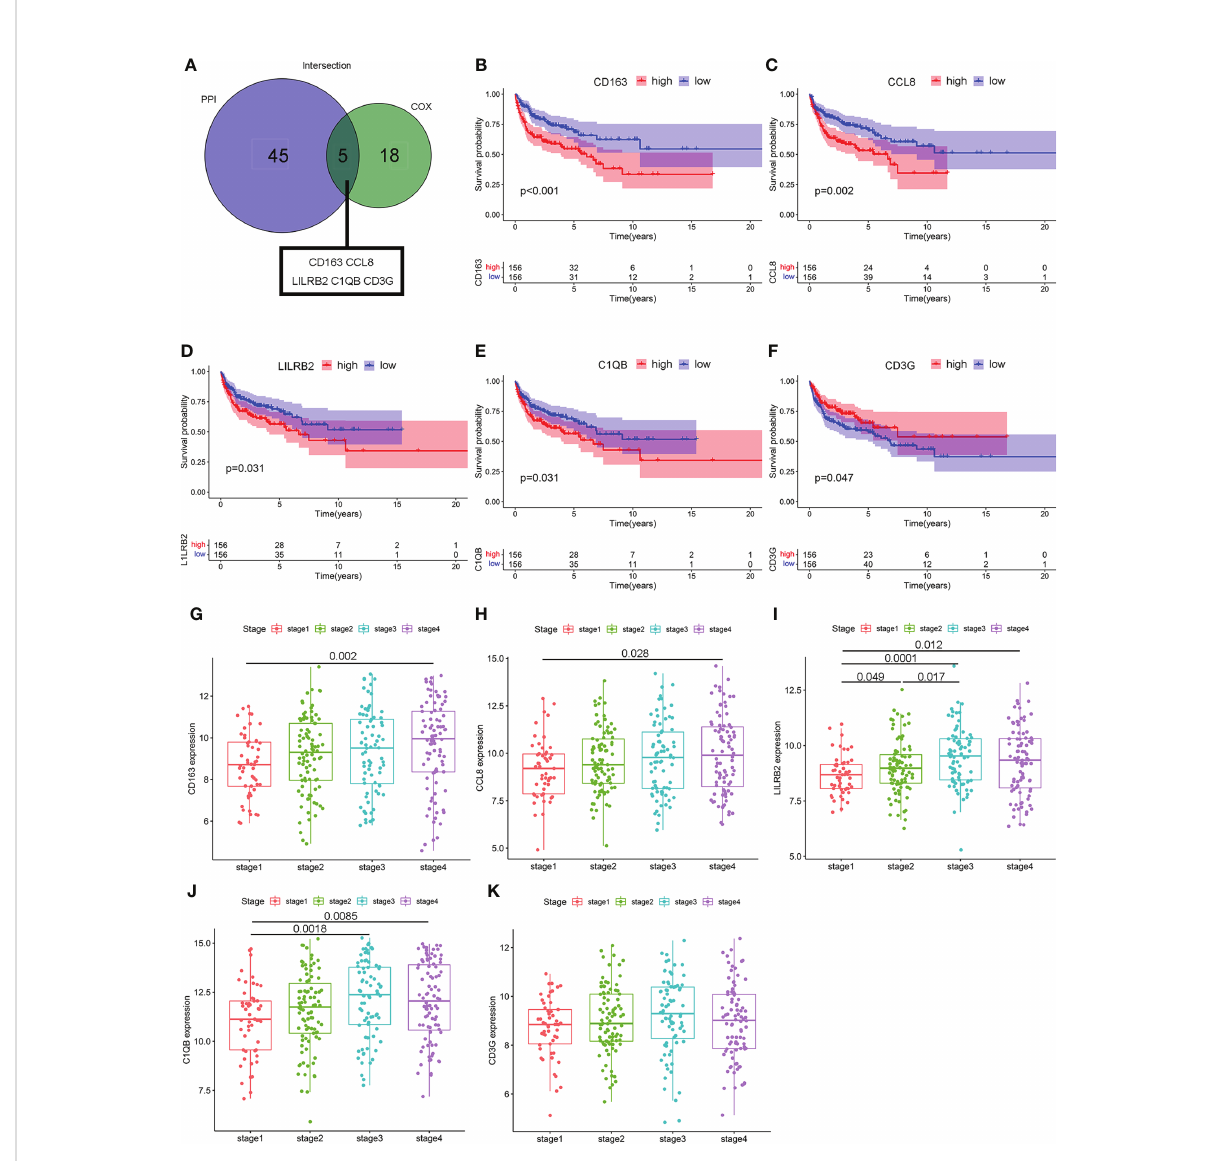
FIGURE 5 The relevance of hub genes to clinicopathologic features and over survival. (A) The Venn diagram indicating intersections of leading 50 nodes in PPI and top signi fi cant factors in univariate COX. (B – F) Kaplan – Meier curves validating survival difference between the high and low expressions of these fi ve hub genes (CCL8, C1QB, CD3G, CD163, and LILRB2). (G – K) Scatter plot showing the association between the expression of fi ve hub genes and clinical